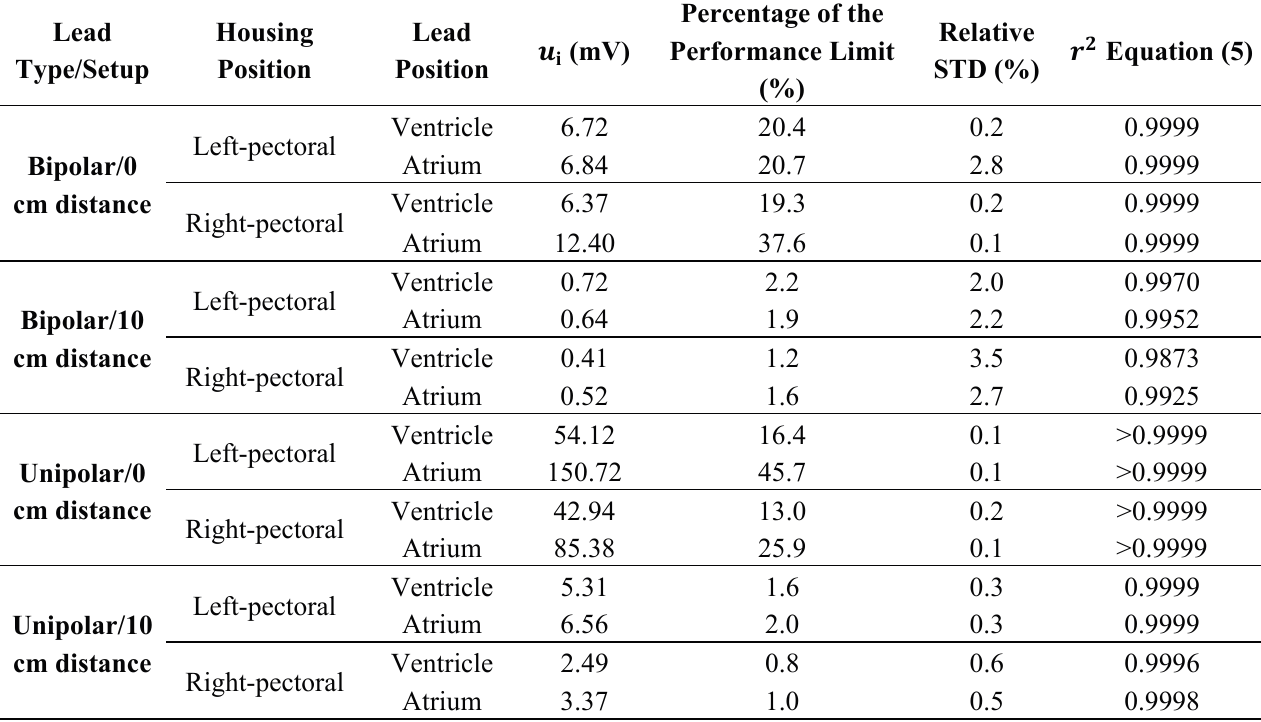
Table 3. Induced voltage at 0 cm distance (worst-case) and at 10 cm distance by the Qi-A13-Board in pinging mode.